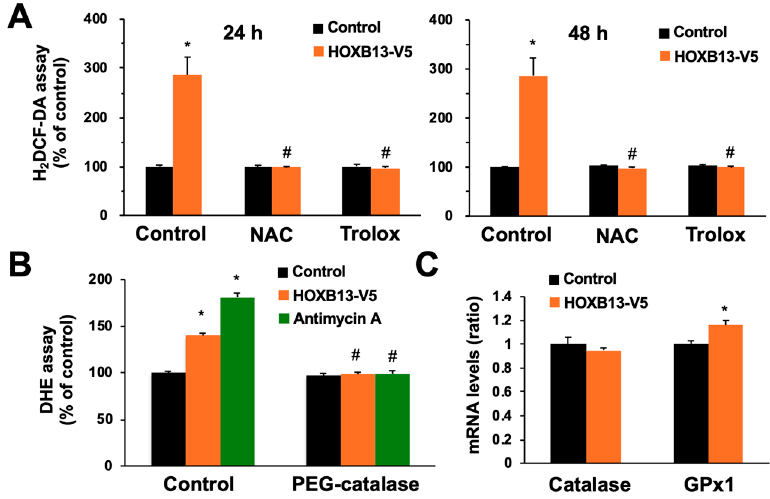
Figure 5. Effects of overexpression of HOXB13 on reactive oxygen species (ROS) production. A549 cells were transfected with control plasmid or HOXB13-V5-expressing plasmid for 24 h and then the cells were re-seeded onto 48-well plates. ( A ) After the re-seeding and culture for 24 h (left panel) or 48 h (right panel) with or without NAC (100 µM) or Trolox (10 µM), ROS levels were measured by DCFDA assay. ( B ) After the re-seeding and culture for 24 h with or without of antimycin A (150 µM) and/or PEG-catalase (1000 U/mL), ROS levels were measured by DHE assay. ( C ) After the re-seeding and culture for 24 h, the mRNA levels of catalase and GPx1 were measured and the relative values normalized to GAPDH are shown. All values are mean ± S.D. of three individual experiments. * p < 0.05 vs. control, # p < 0.05 vs. control group that was transfected with the HOXB13-V5-expressing plasmid.